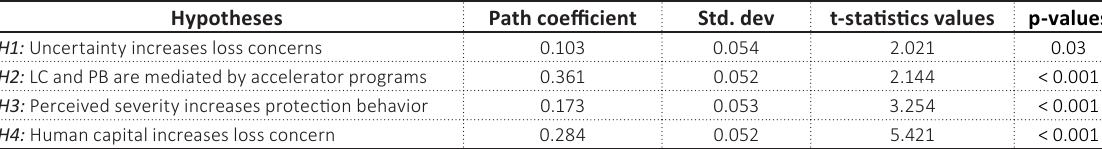
Table 4. Hypotheses